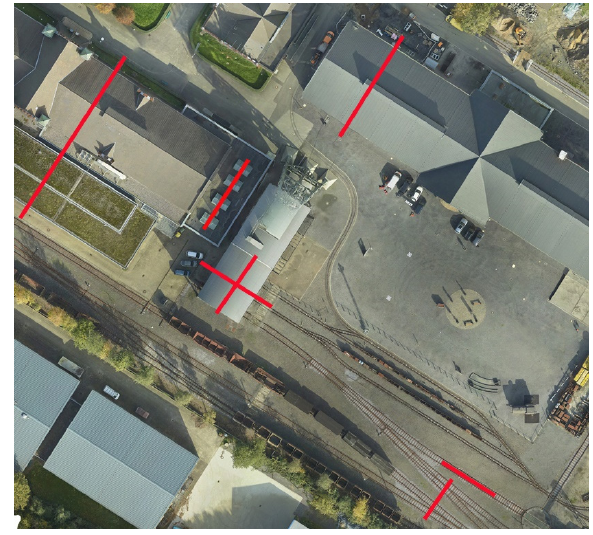
Figure 4. Distribution of profiles in the UAV test field In Figure 5 the height offset of the profiles calculated with Pix4Dmapper is clearly recognizable in comparison to the profiles from PhotoScan. As already demonstrated in the pointwise comparisons, the Pix4D profiles are also systematically located above those of the PhotoScan computation. In Figure 6 the shape of each single profile is additionally depicted for better illustration. Fundamentally, the respective profiles of the two software packages correspond to each other, but the profiles of PhotoScan are obviously smoothed due to the applied filter factor of "aggressive".